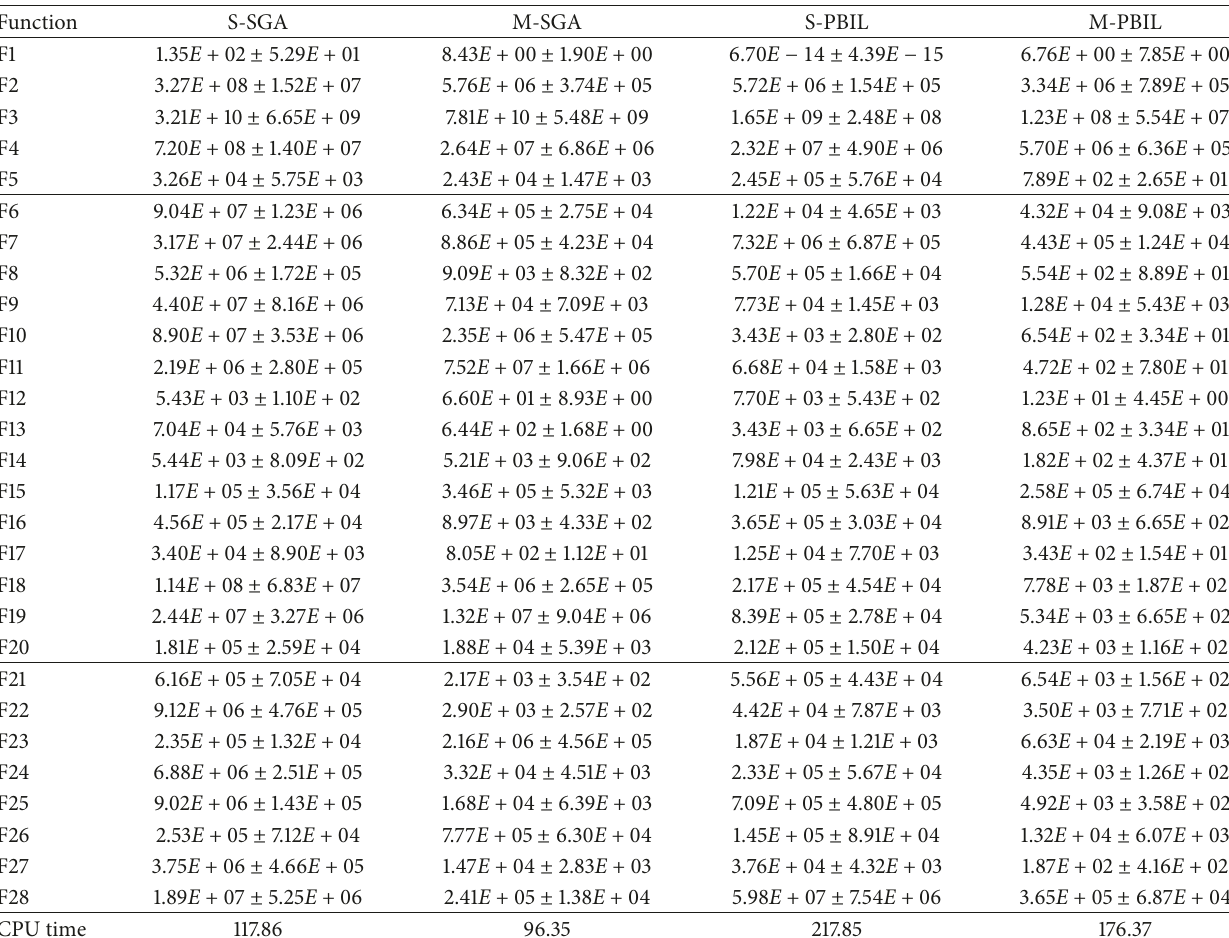
Table 2: Comparisons of the best error values of the 2013 CEC benchmark functions for SGA and PBIL. In the table, “S-” and “M-” denote the single-population version and multipopulation version of algorithms, respectively. Here [ 𝑎 ± 𝑏 ] indicates the mean value and the corresponding standard deviation of 25 independent simulations. Average CPU times (minutes) are shown in the last row of the table.